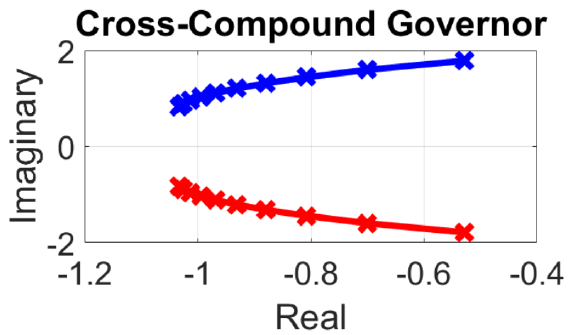
Figure 5. Impact of H on closed-loop poles for Cross-Compound Governor.